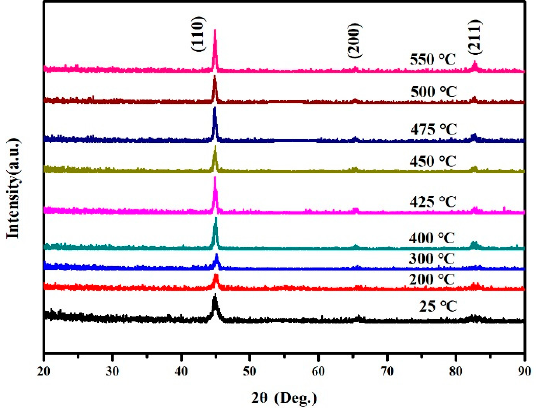
Figure 4. GI-XRD patterns for FeCo thin films with thickness of 800 nm deposited at different tem- peratures. Figure 5. GI-XRD patterns for FeCo thin films with thickness of 50 nm deposited at different tem- peratures.